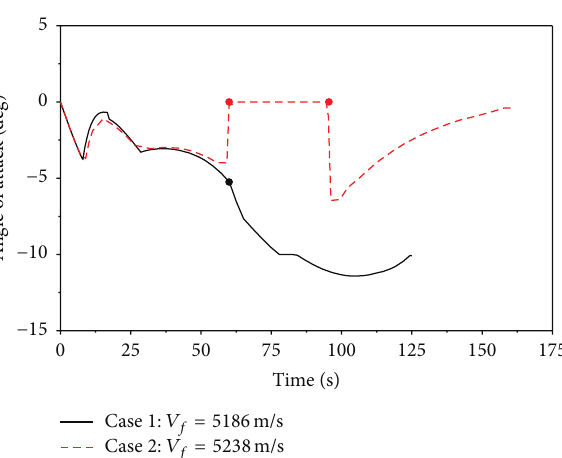
Figure 1: Ascent trajectories.